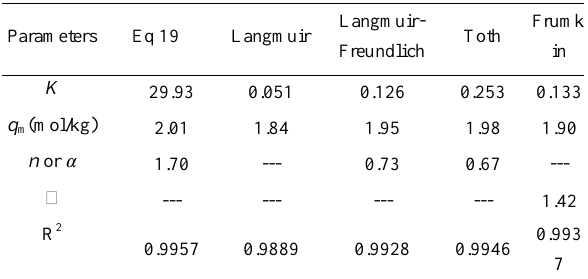
Table 2. The obtained parameters of isotherms for C adsorption on zeolite 13x at 303.15 K.